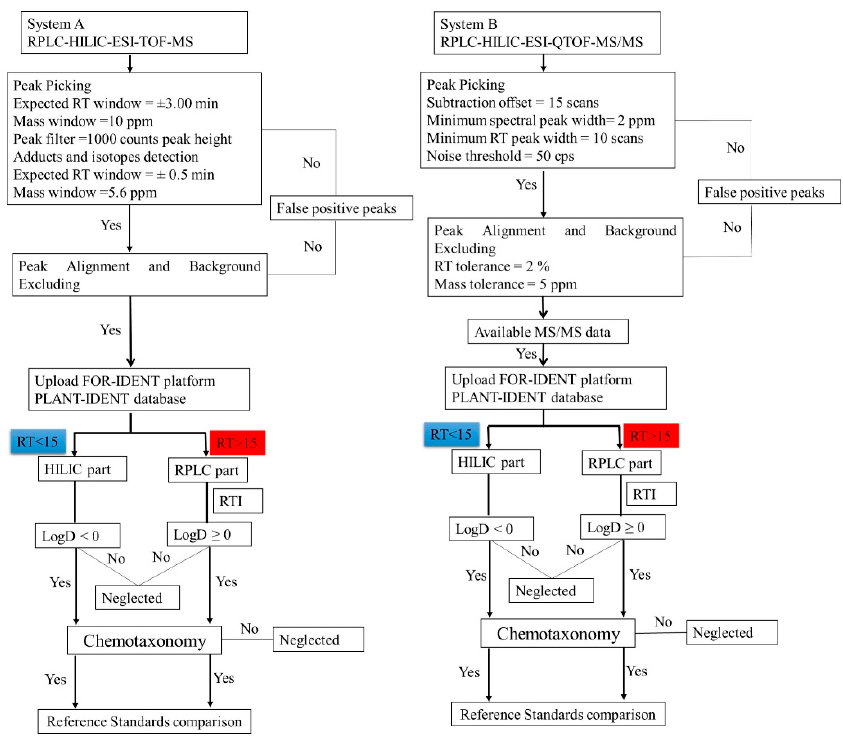
Figure 1. The non-target workflow flowchart (from precursor ion mass to ‘molecular names’) using a RPLC-HILIC-ESI-TOF-MS (system A) and evaluating the analytical data (including MS/MS) obtained with RPLC-HILIC-ESI-QTOF-MS/MS (system B). The parameters of peak picking and alignments were set according to the internal standards. The features were prioritized using the PLANT-IDENT database in the FOR-IDENT platform after various data filtration steps. The workflow of the data analysis with system A was also mentioned in [8,20].